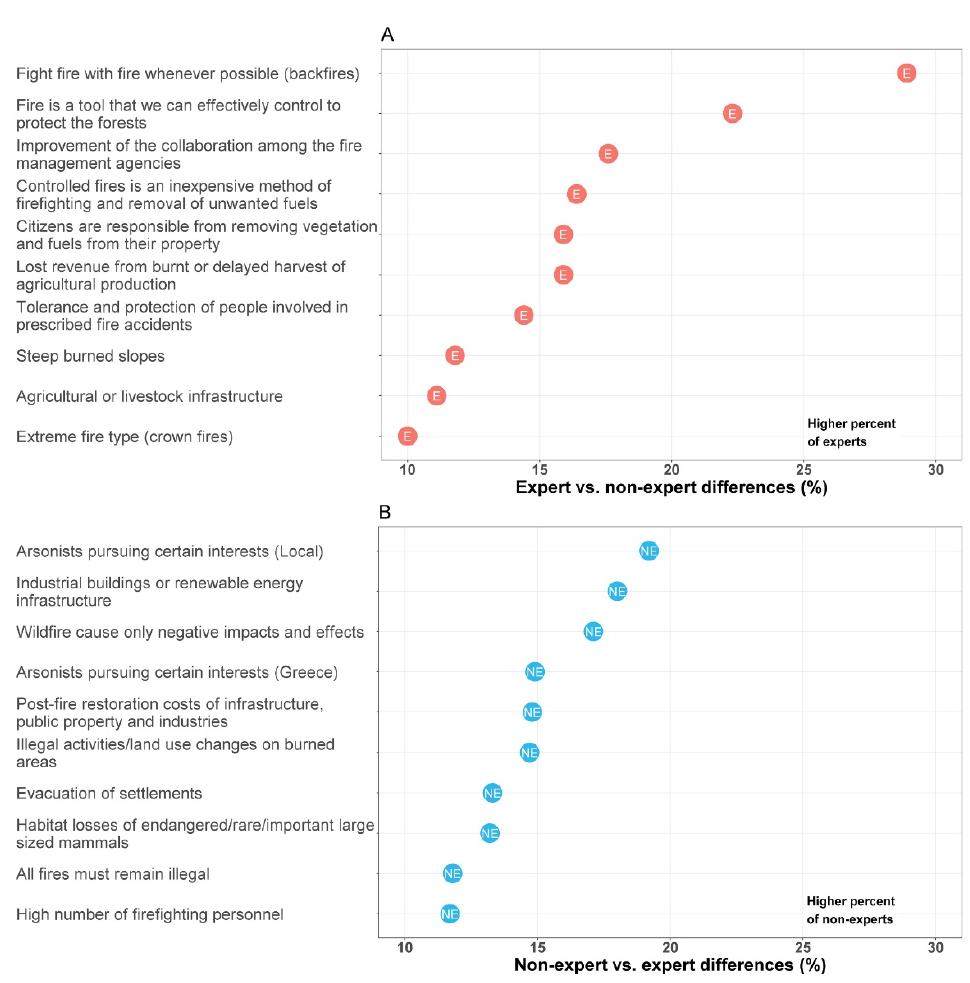
Figure 8. Percentage differences in the number of responses for different ratings of questions for those respondents characterized as experts relative to non-experts ( A ) and non-experts relative to experts ( B ). The number of respondents that answered each question with Somewhat or Strongly Agree, Very or Extremely important, and High or Very High effect were summed by respondent class (i.e., experts relative to non-experts) and converted to percentages from the total of each class. Experts are described with a red “E” point and non-experts with a blue “NE” point. Note that only strong differences (>10% of the number of respondents for each group) are shown.